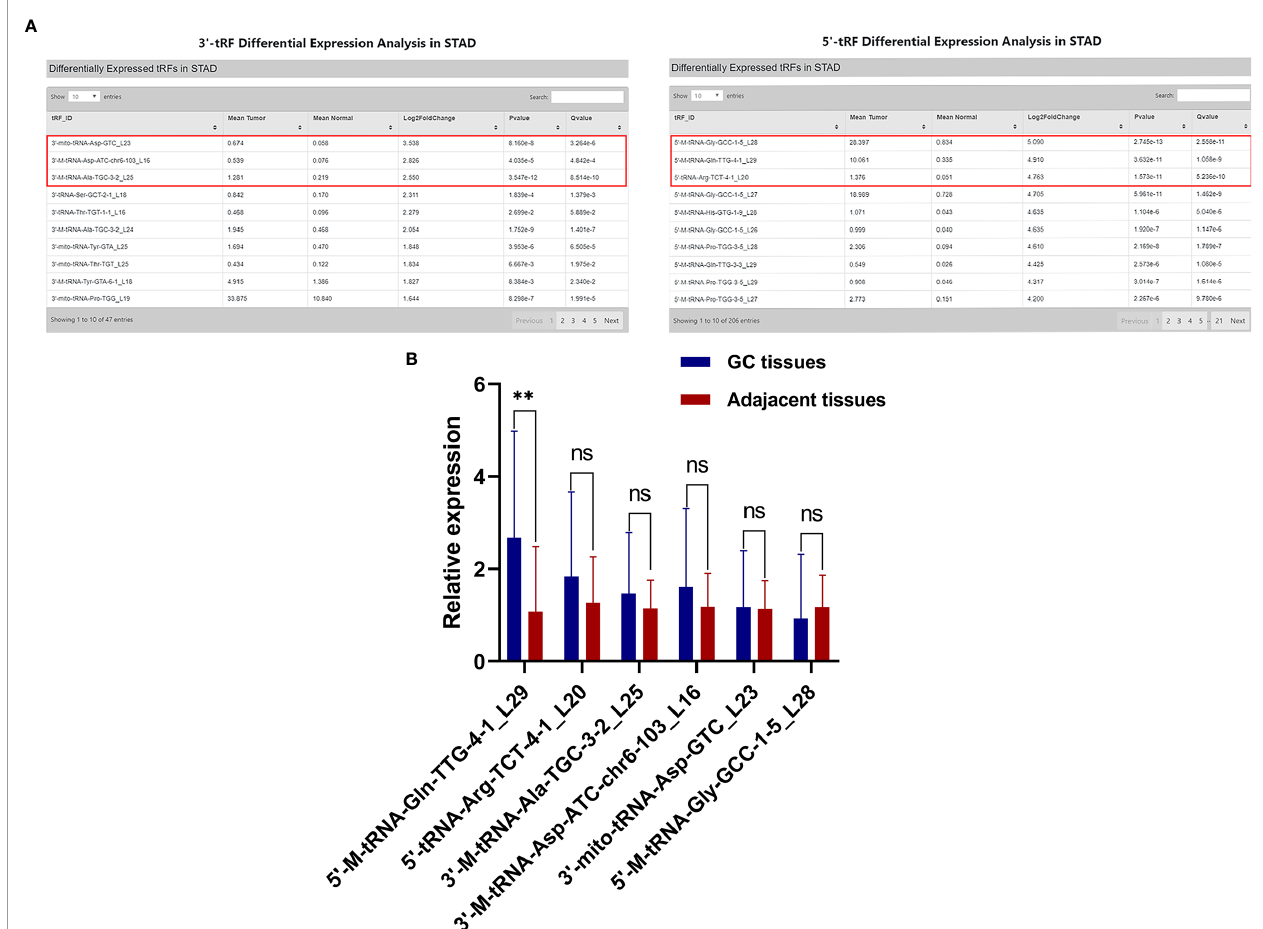
FIGURE 1 | Screening of hsa_tsr016141. (A) Three 3 ’ tRF and 5 ’ tRF were sorted by the standard of the most signi fi cant log 2 fold change, and their P values were all less than 0.05. (B) Expression levels of 6 tRFs in GC tissues. **P < 0.01, ns P >